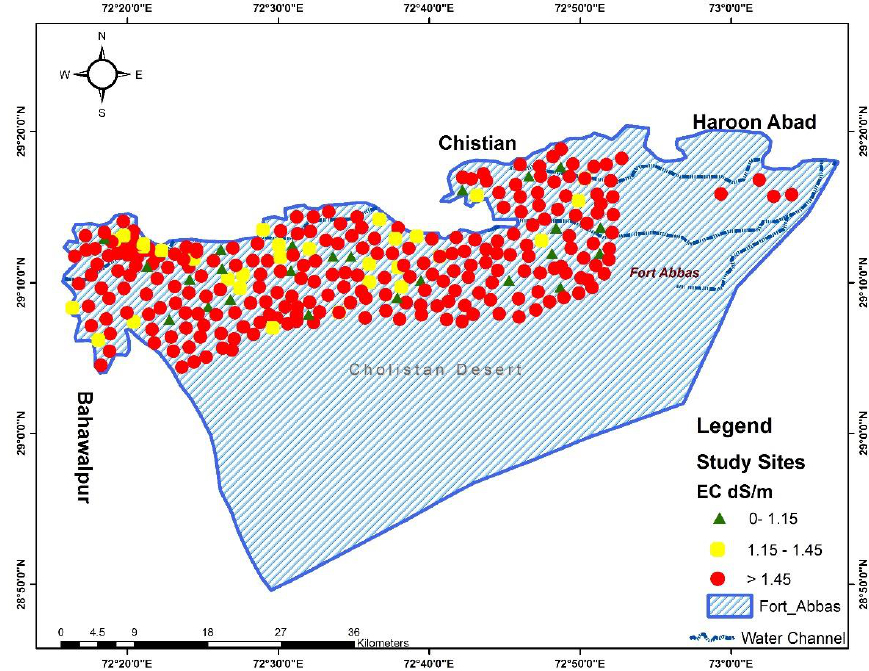
Figure 2. Status of electrical conductivity (EC) of groundwater in Tehsil Fort Abbas.